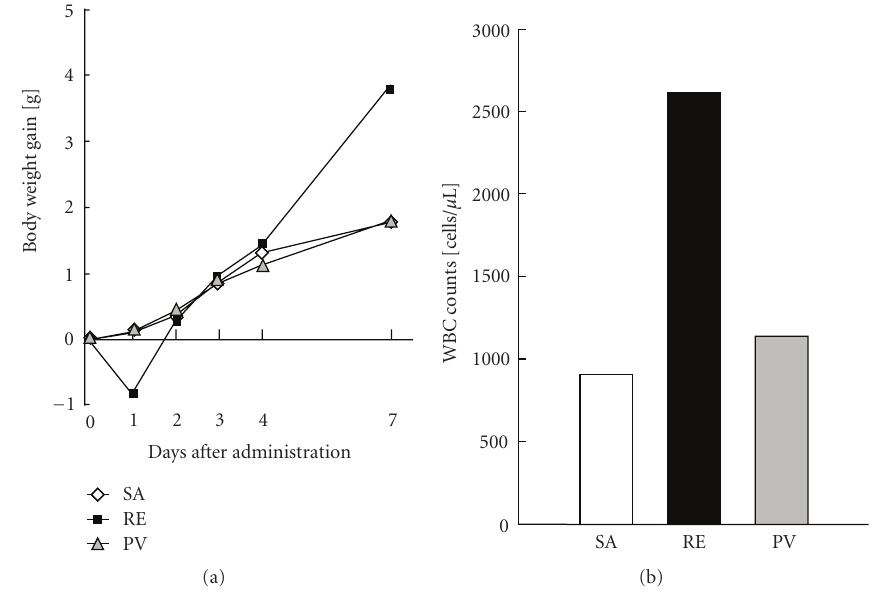
Figure 1: Safety control tests for pertussis vaccines. (a) Test for toxicity to mouse weight gain. Physiological saline (SA), an inactivated whole-cell pertussis vaccine (RE), or an acellular pertussis vaccine (PV)-administered mice were weighed on 0, 1, 2, 3, 4, and 7 days postadministration. Ten mice in each group were used, and the mean changes in body weight are indicated. (b) Leukocytosis promoting activity of various pertussis vaccines. White blood cell (WBC) counts in peripheral blood were measured 3 days after vaccine administration. Ten mice in each group were used and the mean WBC counts are indicated.